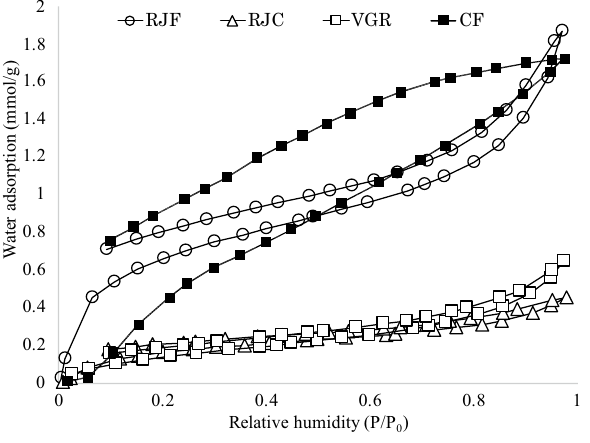
Fig. 12 Thermogravimetric curves of VGP and clay powder